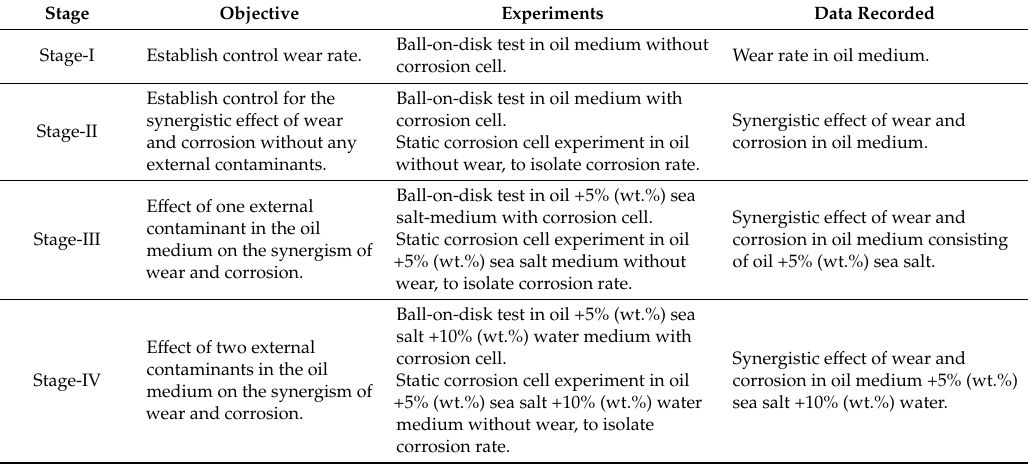
Table 3. Experimental designs aimed at analyzing the effectiveness of the retrofitted tribo-corrosion test rig and investigating the tribo-corrosion in Dextron III oil medium.